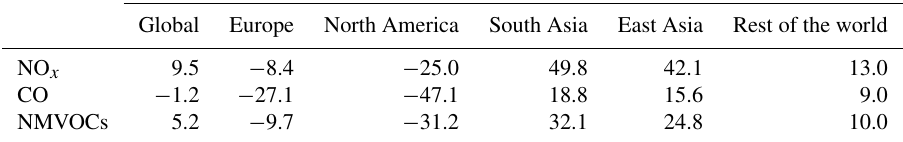
Table 2. Summary of multi-model annual mean surface ozone values from all TF-HTAP1 models in 2001 (H-1), the parameterisation